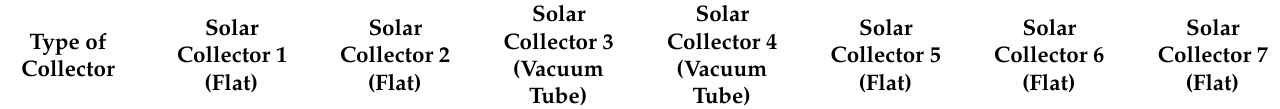
Table 6. Results of the method with considering qualitative and environmental